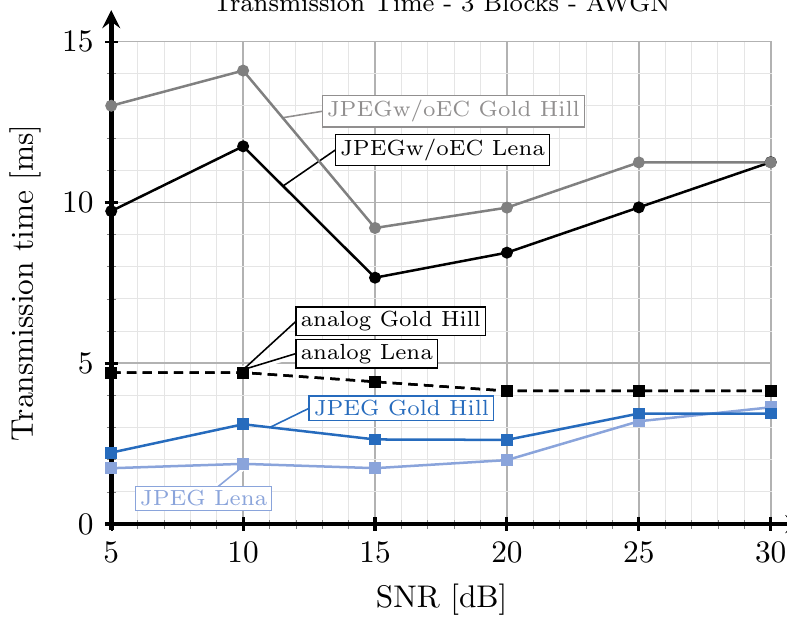
Figure 9. Transmission time vs. SNR for three blocks and AWGN channel.